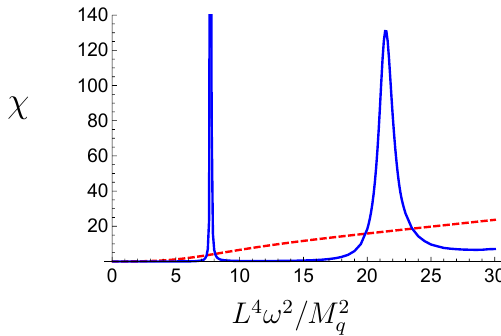
Figure 2 . Spectral function described in the text (with arbitrary normalization) for (cid:15) = 1 (dashed, red curve) and (cid:15) = 1 = 100 (solid, blue